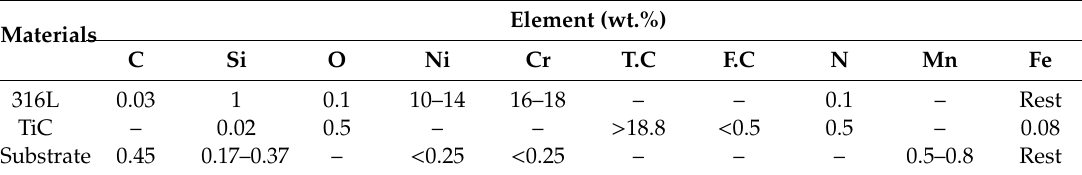
Table 1. Element composition (wt.%) of cladding powder and